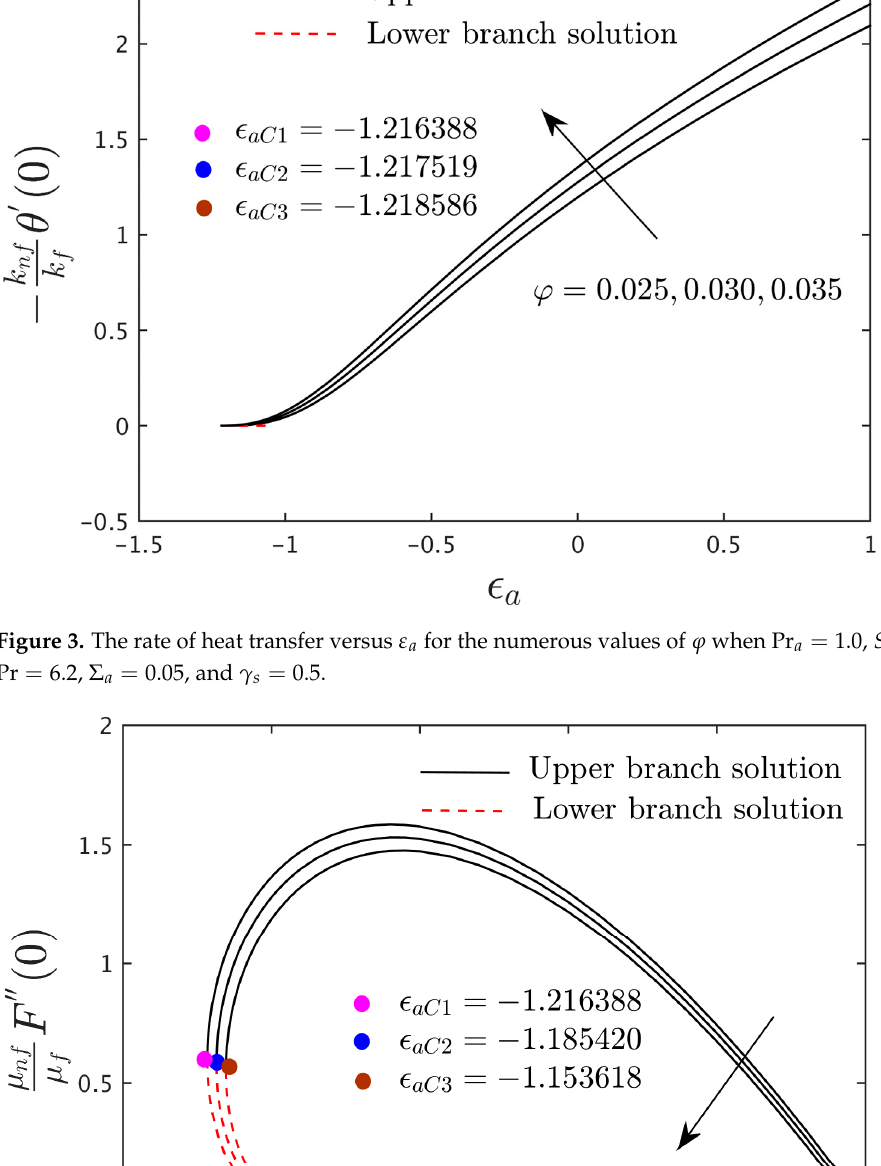
Figure 2. The friction factor versus